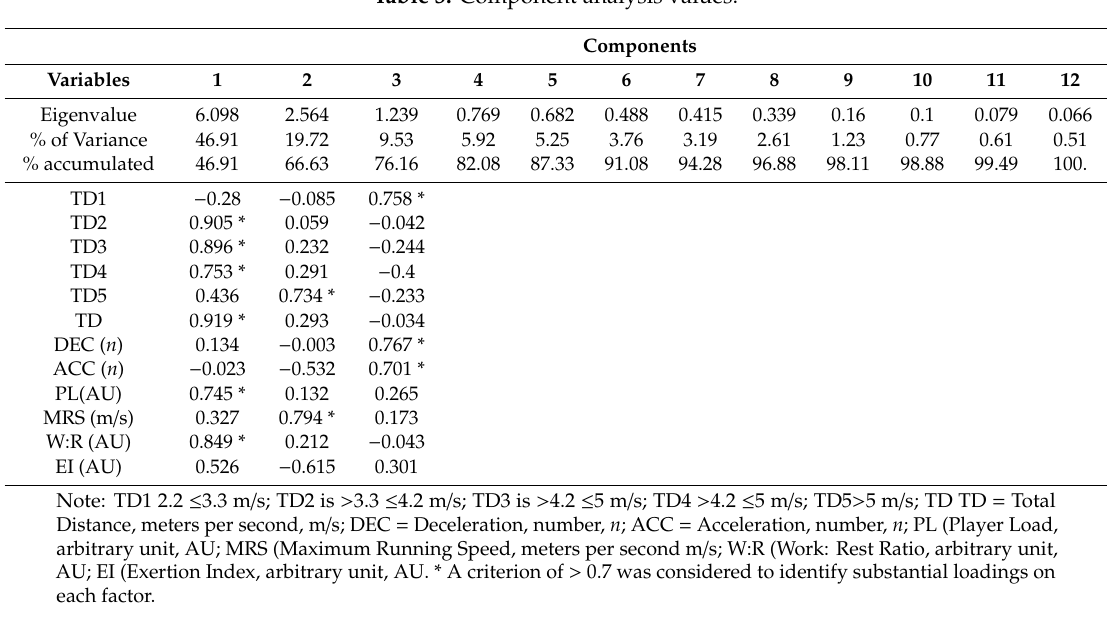
Covered in Di ff erent Range of Speed (from > 2.2 to ≤ 3.3 m / s, from > 3.3 to ≤ 4.2 m / s and > 4.2 ≤ 5 m / s),